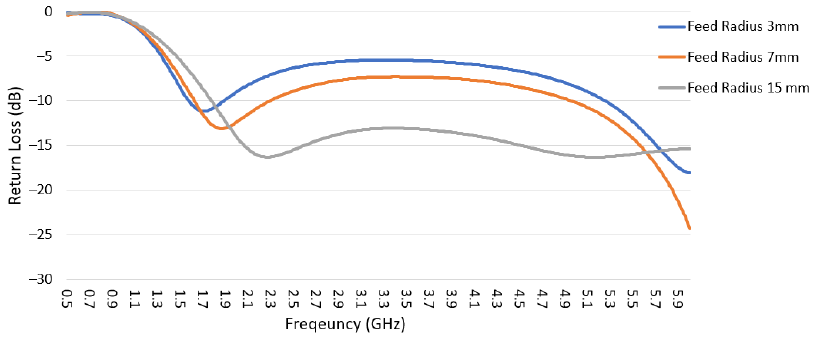
Figure 10. Return loss for the three feeding sizes is shown in Figure 8.